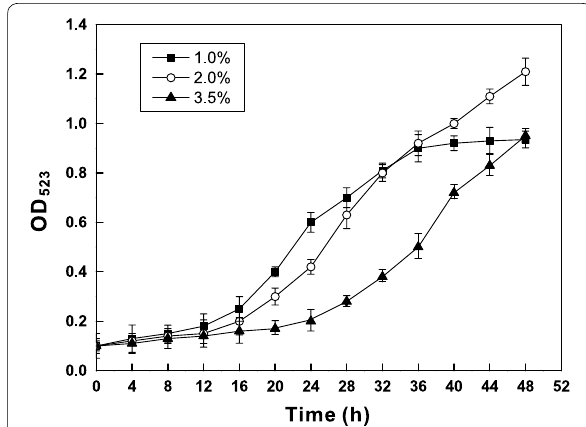
Fig. 8 Growth curve of strain Gan‑35 during growth in the high salt medium. The concentrations of NaCl in the medium were set at 1.0, 2.0, and 3.5% (w/v), respectively. The absorbance of the culture at 523 nm was measured every 4